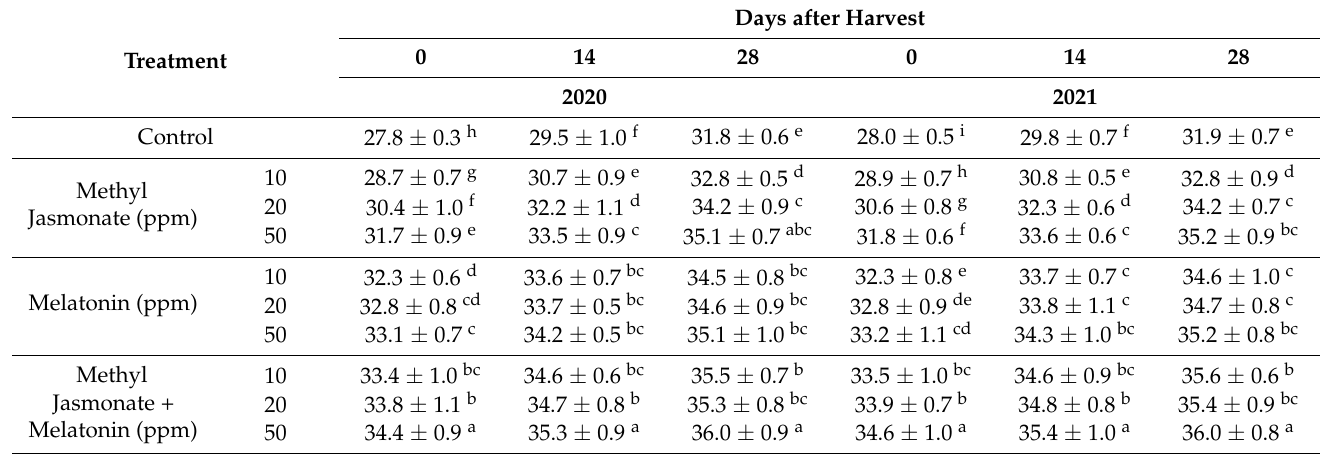
Table 5. Effects of foliar application of melatonin and/or methyl jasmonate solutions at different concentrations on the total soluble solids content (TSS, ◦ Brix) in date palm fruits (cv. Barhi) stored at 4 ◦ C for 28 days *.